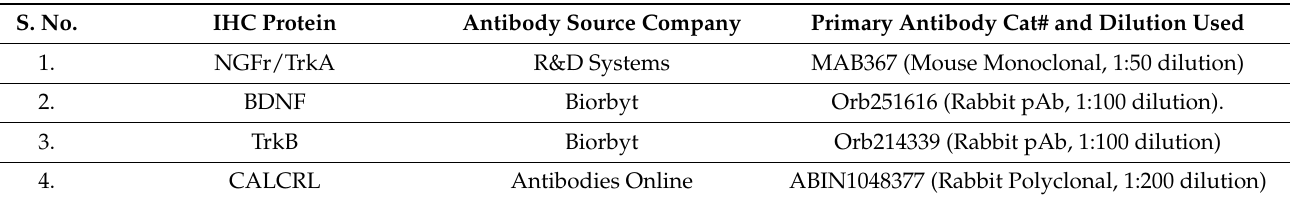
Table 2. List of antibodies (source and concentration used) for canine and human IVD sections. S.